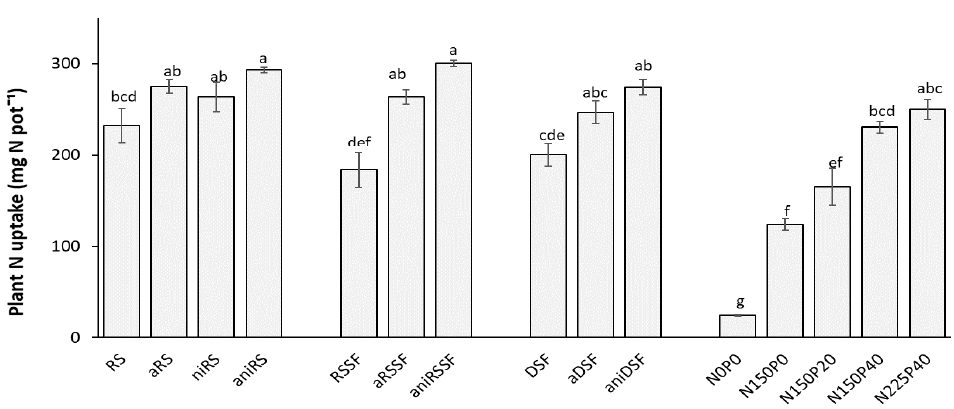
Figure 5 . Total N uptake for untreated and acidified organic products and reference mineral fertilizers 35 days after sowing (DAS) as mean values of 4 replicates. RS: Raw slurry; RSSF: Raw slurry solid fraction; DSF: Digestate solid fraction; a: Acidified; ni: Nitrification inhibitor; ani: acid + ni; NxPy: mineral N and P reference fertilizer at x mg N and y mg P kg − 1 soil. Error bars represent standard error of the mean ( n = 4). Treatments with different letters (across all levels) are significantly different ( p < 0.05) according to the Tukey test.